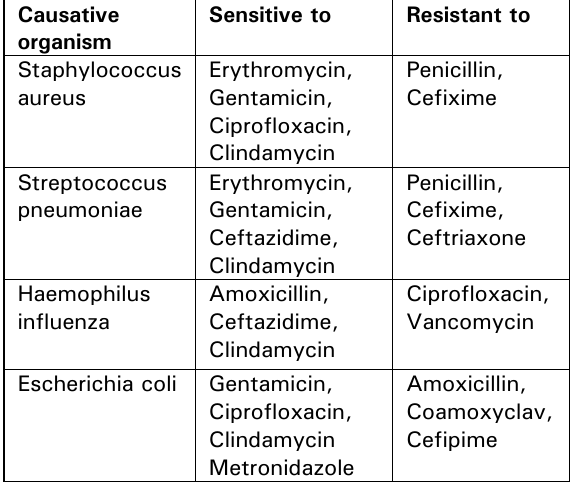
Table 3: sensitivity